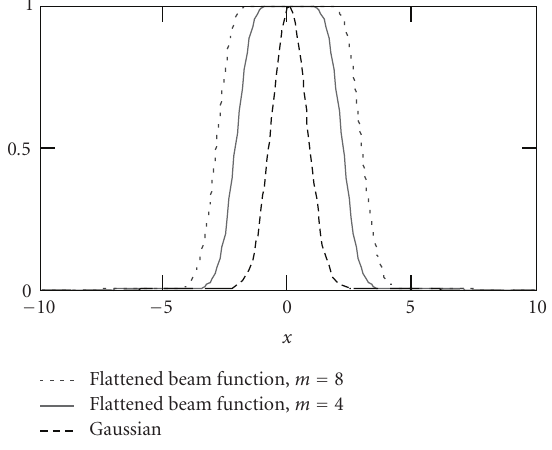
Figure 3.2. Flattened beam (dotted: m = 8, continuous: m = 4) and Gaussian